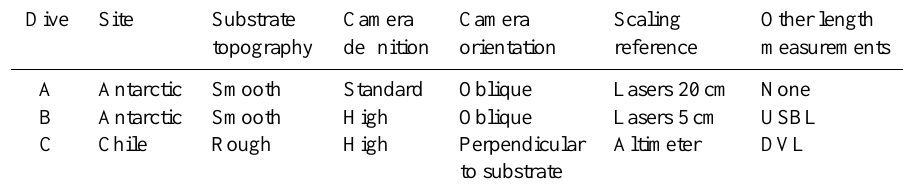
Table 1. Main parameters of the sites and set-ups for the three ROV dives. Dive Site Substrate Camera Camera Scaling Other length topography definition orientation reference measurements A Antarctic Smooth Standard Oblique Lasers 20cm None B Antarctic Smooth High Oblique Lasers 5cm USBL C Chile Rough High Perpendicular Altimeter DVL to